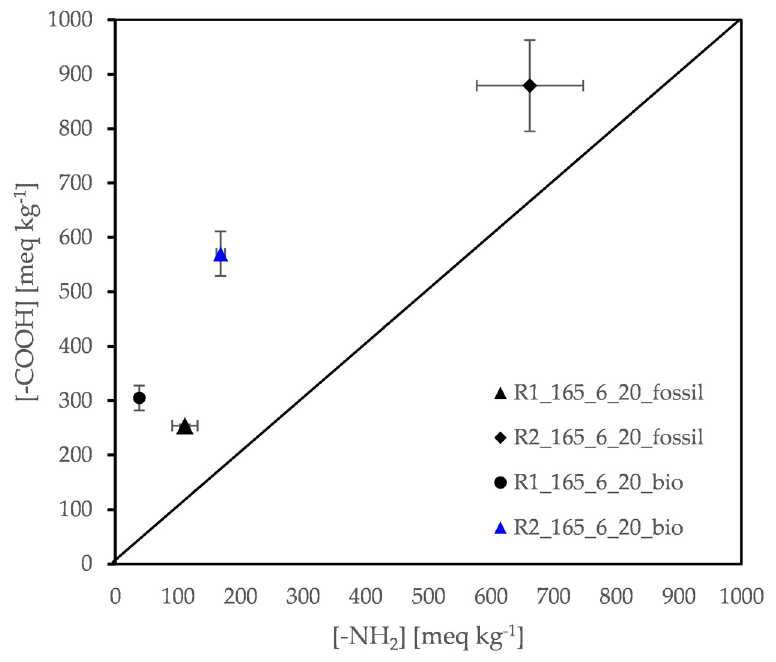
Figure 8. Effect of reactor design: amine and carboxyl end-group concentration of R1 and R2 products. Table 6. Effect of reactor design: thermal properties of R1 and R2